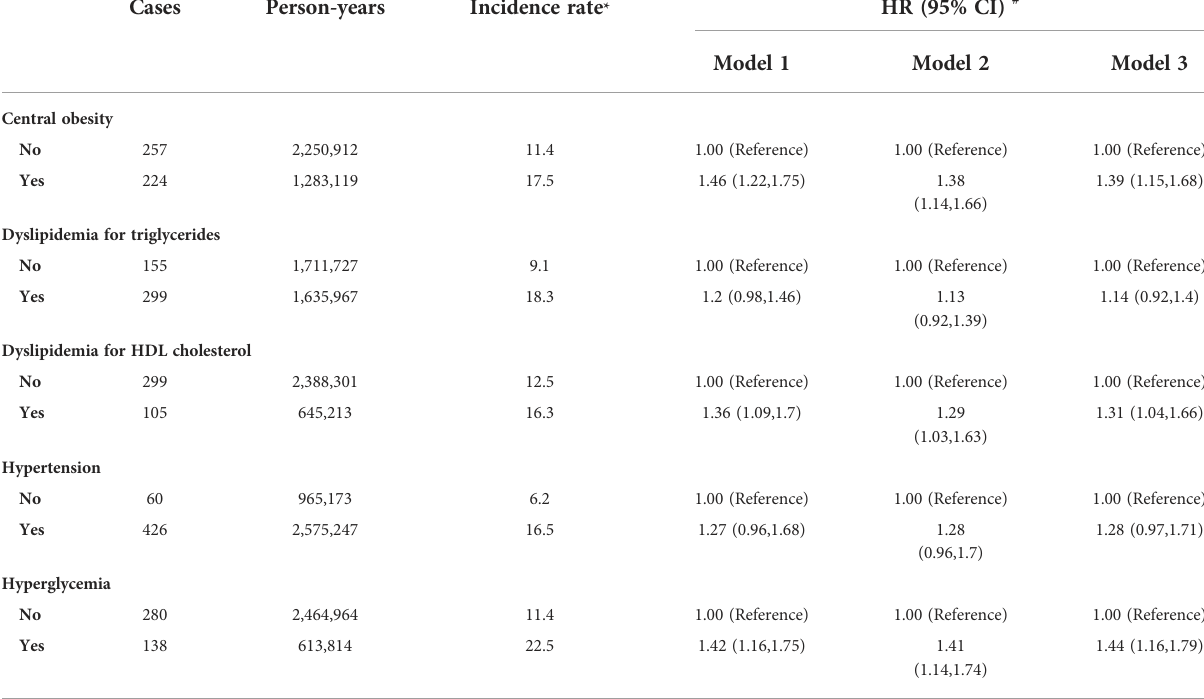
TABLE 3 Risk of bladder cancer according to each component of metabolic syndrome.